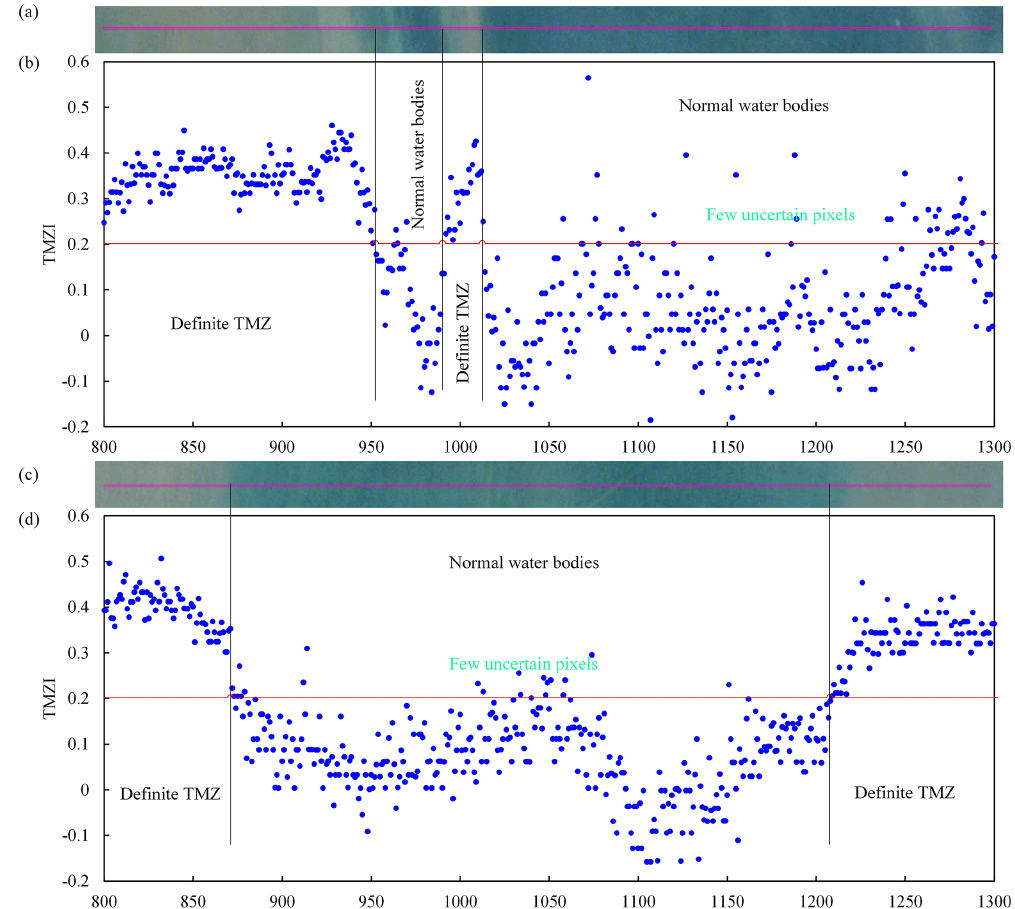
Figure 6. The true color imagery and the corresponding values of the TMZI of rows 1200 (a, b) and 1900 (c, d) .